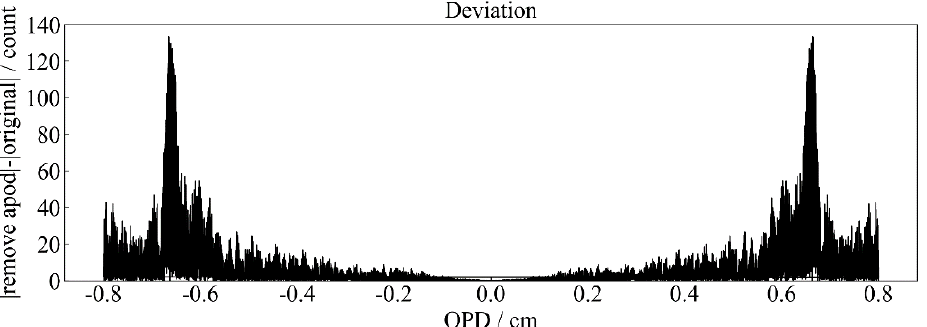
Figure 3. IASI interferogram deviation comparison after apodization.